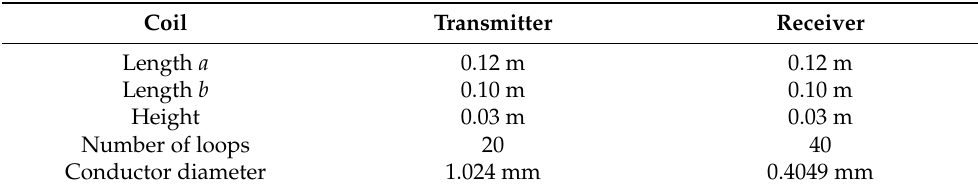
Table 2. Characteristics of the